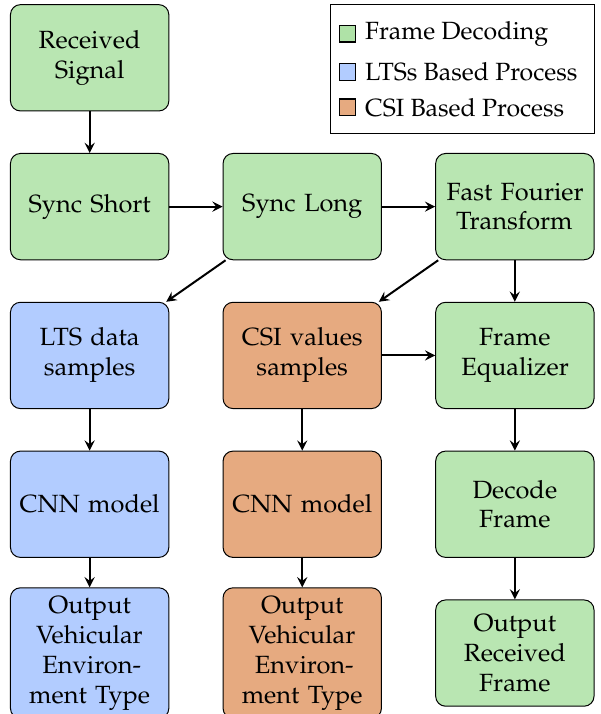
Figure 3. Flow chart describing vehicular environment identification process.